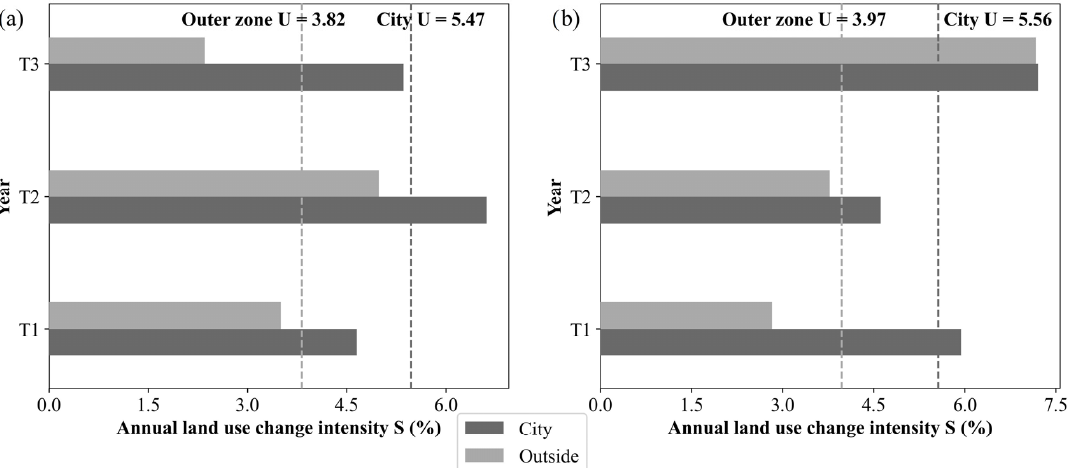
Figure 3. Interval level changes in terms of intensity during three study periods in ( a ) Dharamsala and ( b ) and ( b ) Pithoragarh.